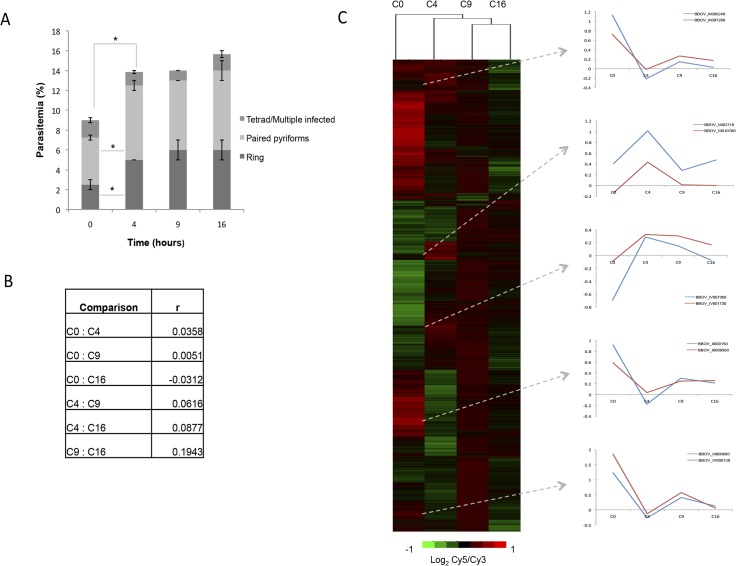
Molecular descriptors characterizing the IDC of B. divergens parasites.(A) Morphological evaluation of B. divergens life cycle progression from a newly initiated culture over a total of 16 hours, indicating the distribution of life cycle stages to total parasitemia. (B) Pearson correlations of the mRNA abundance levels of B. divergens parasites in an initiate culture compared to parasites that adapted to culture for 4, 9 and 16 hours, respectively. (C) Cy5-labelled cDNA from B. divergens parasites across four different times (0, 4, 9, 16 hours post-inoculation) were hybridized to Cy3-labelled cDNA from a reference pool spanning all samples. Transcripts were clustered according to expression values (M-values, log2 Cy5/Cy3) of the initiate culture, with the expression profiles of representative genes indicated. On the heat map, scale (log2 Cy5/Cy3) is from 1 to -1. Transcripts were classified based on their dCAS annotation and COG classification compared to B. bovis homologs.